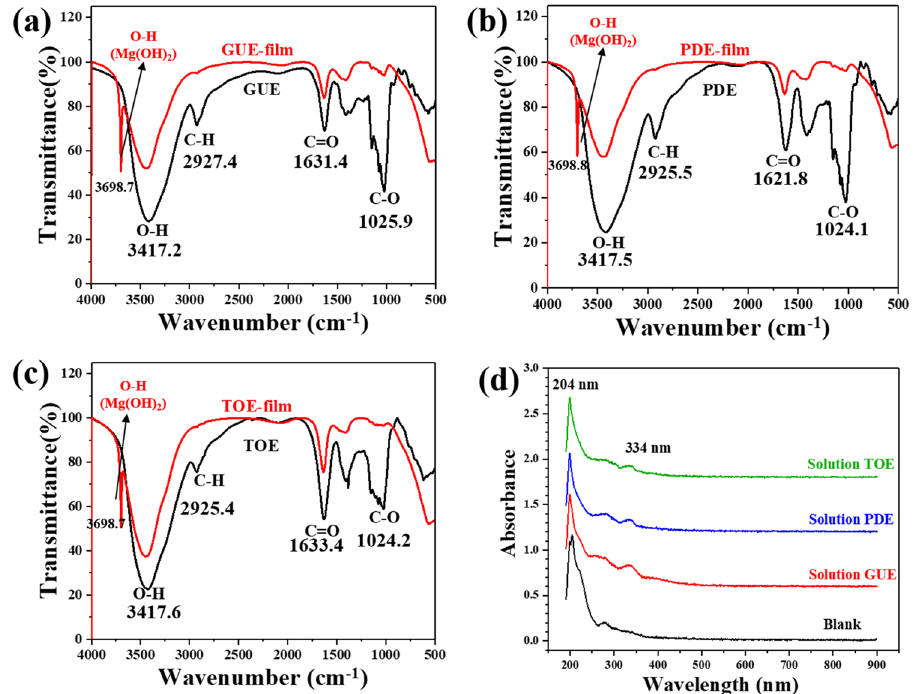
Figure 7. ( a – c ) show the FTIR spectra for pure GUE, PDE, TOE and the absorbed products extracted from the substrate surfaces after immersing in 3.5 wt% NaCl solution containing GUE, PDE, TOE, respectively. ( d ) UV–vis of 3.5 wt% NaCl solution devoid of and containing GUE, PDE, TOE after 24 h of immersing a AZ91 Mg alloy